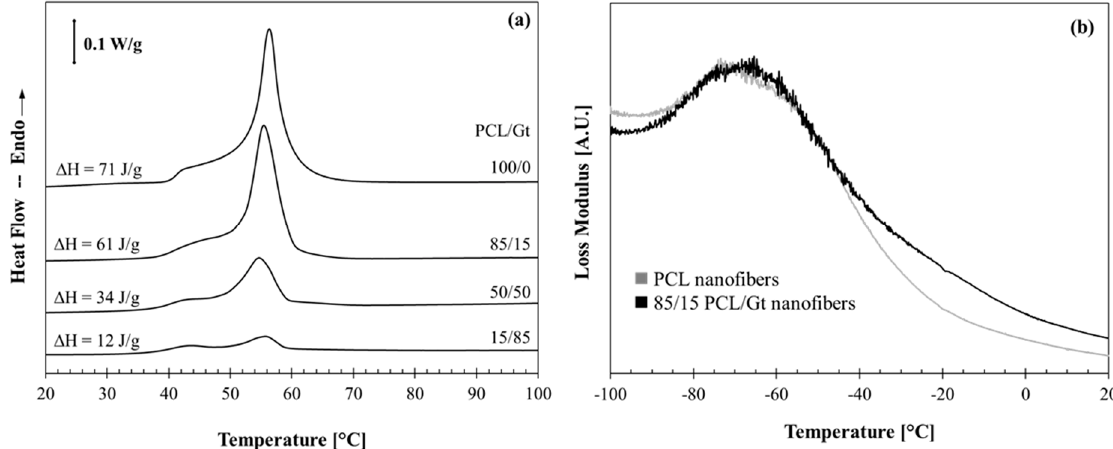
Figure 5. The effect of blending with gelatin, using a 70/30 AA/FA solvent system, on ( a ) the melting behavior and ( b ) the glass transition of PCL-based nanofibers measured by DSC at 2.5 K · min − 1 and by DMA respectively.